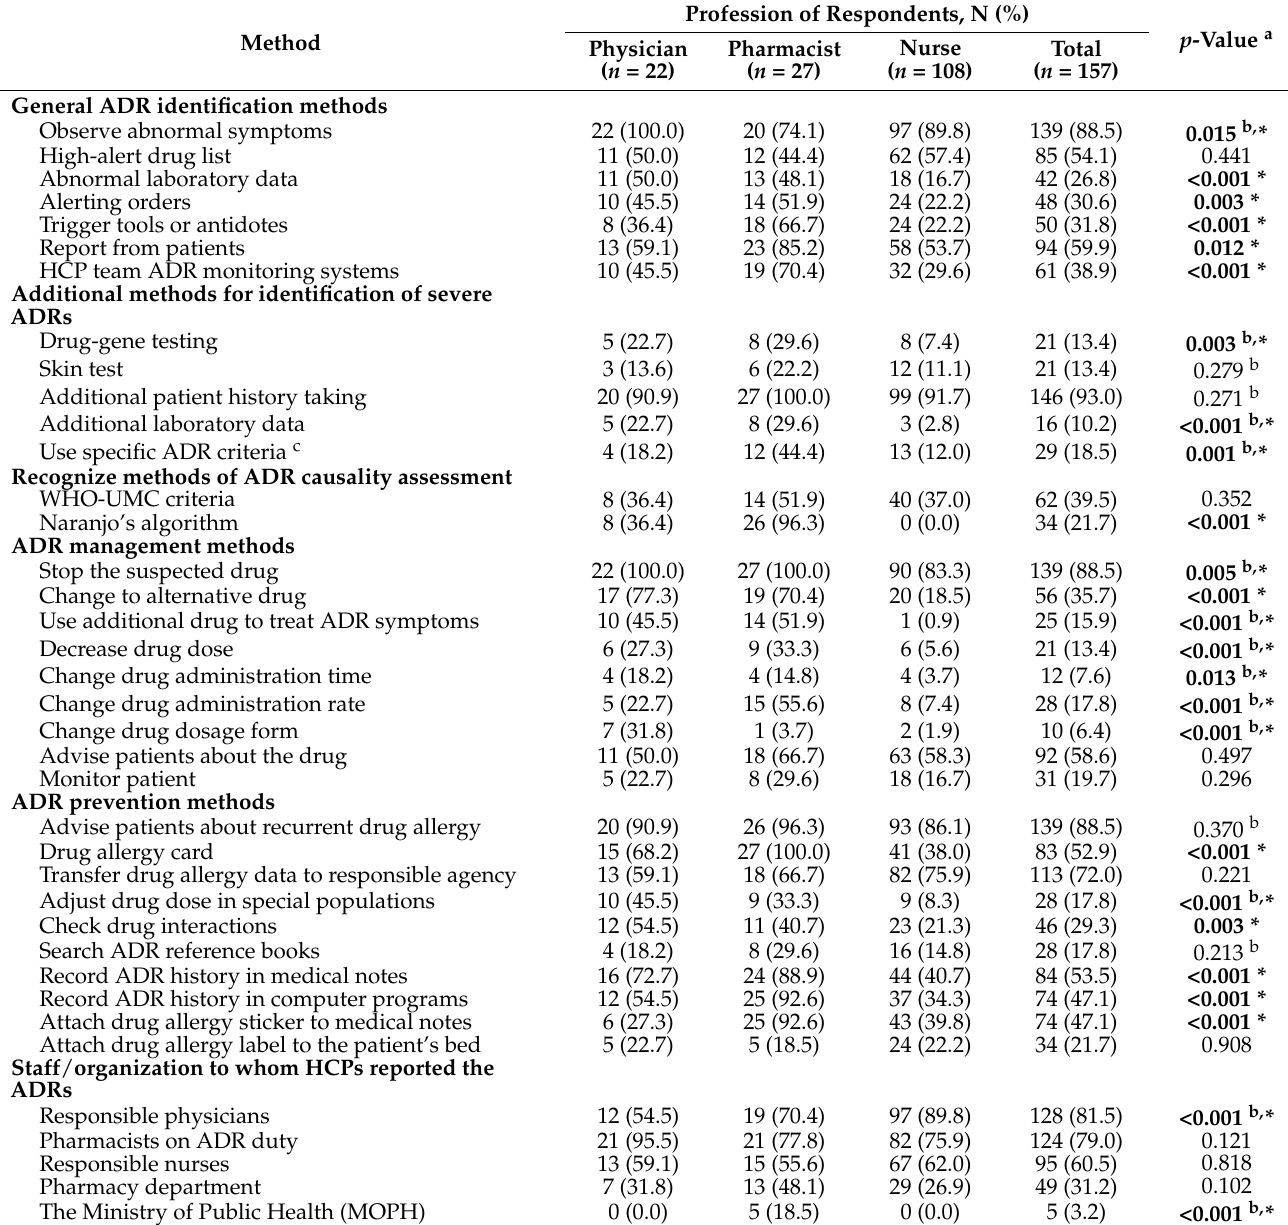
Table 2. Methods of ADR monitoring by